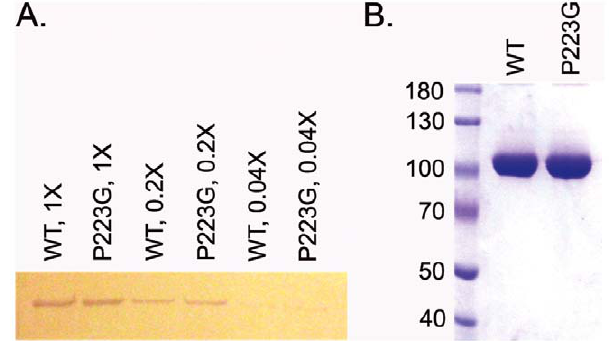
Figure 3. Comparison of the expression levels of WT AcrB and AcrB P223G . A. Western blot analysis of membrane vesicles extracted from BW25113 D acrB expressing WT AcrB (WT) or AcrB P223G (P223G). Each sample was diluted 1, 5, and 25 folds. B. SDS-PAGE analysis of purified WT AcrB and AcrB P223G . The expression levels of the WT and AcrB P223G are similar. doi:10.1371/journal.pone.0028390.g003 PLoS ONE |